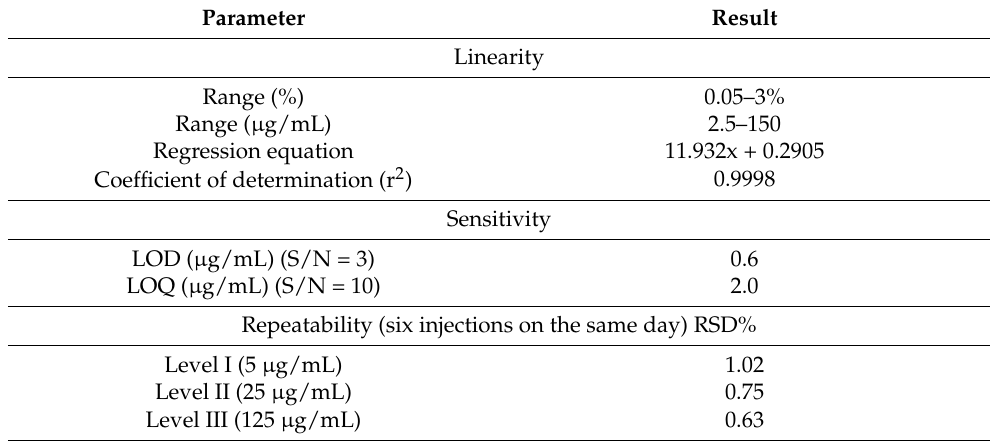
Table 3. Summary of the data obtained during method